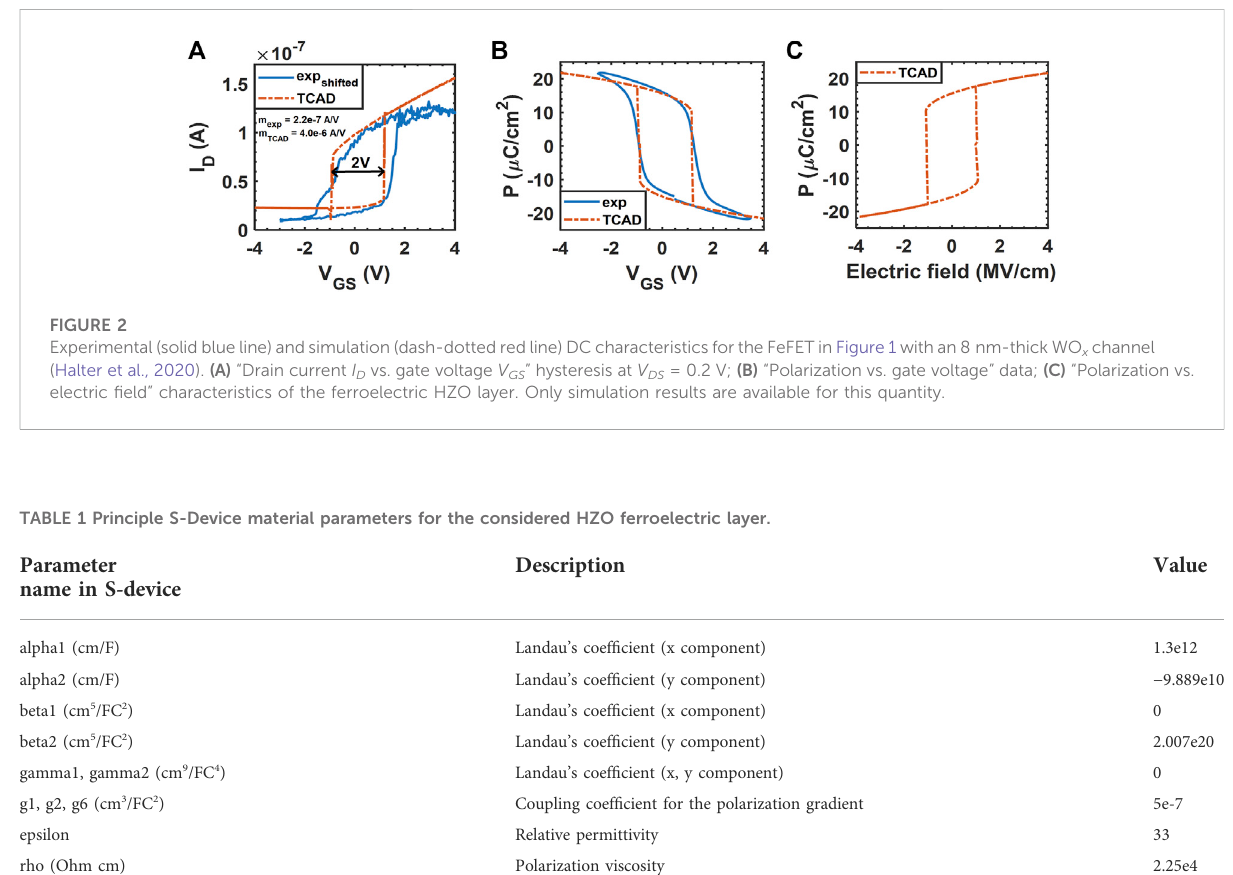
TABLE 2 Same as in Table 1, but for the WO x